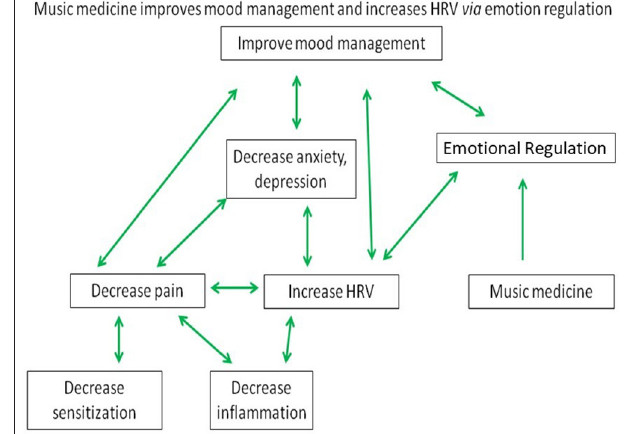
FIGURE 3 | Multifactorial regulation of HRV by music medicine. Proposed Model for Music Medicine to improve mood management and HRV via emotional regulation integrating the regulation of pain, inflammation, anxiety, and depression.